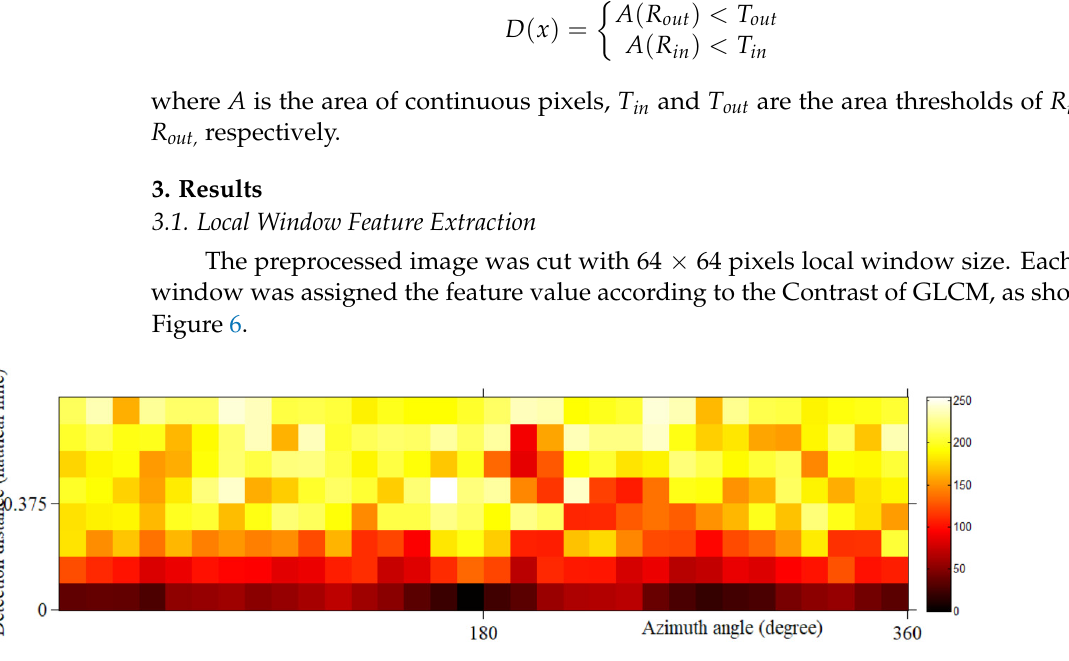
Figure 6. Contrast characteristic value of local window.